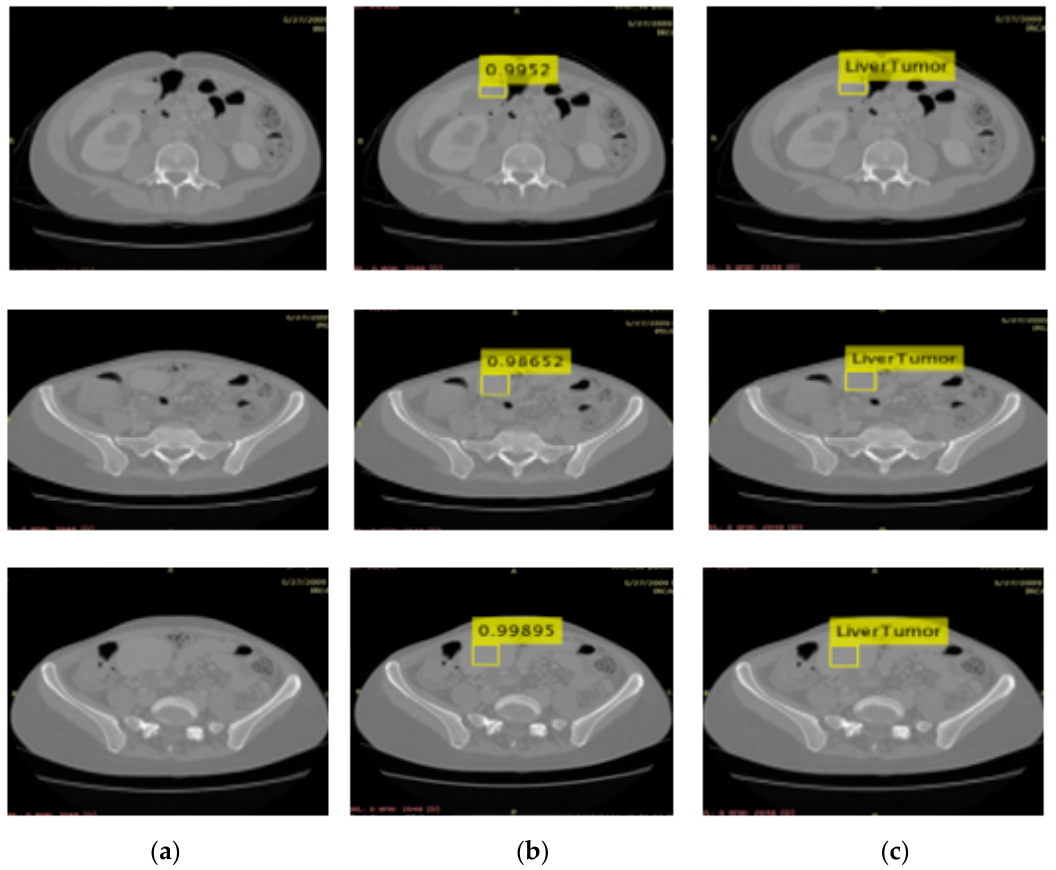
Figure 9. Results of tumor localization ( a ) CT input ( b ) localized liver tumor. ( c ) tumor localization with